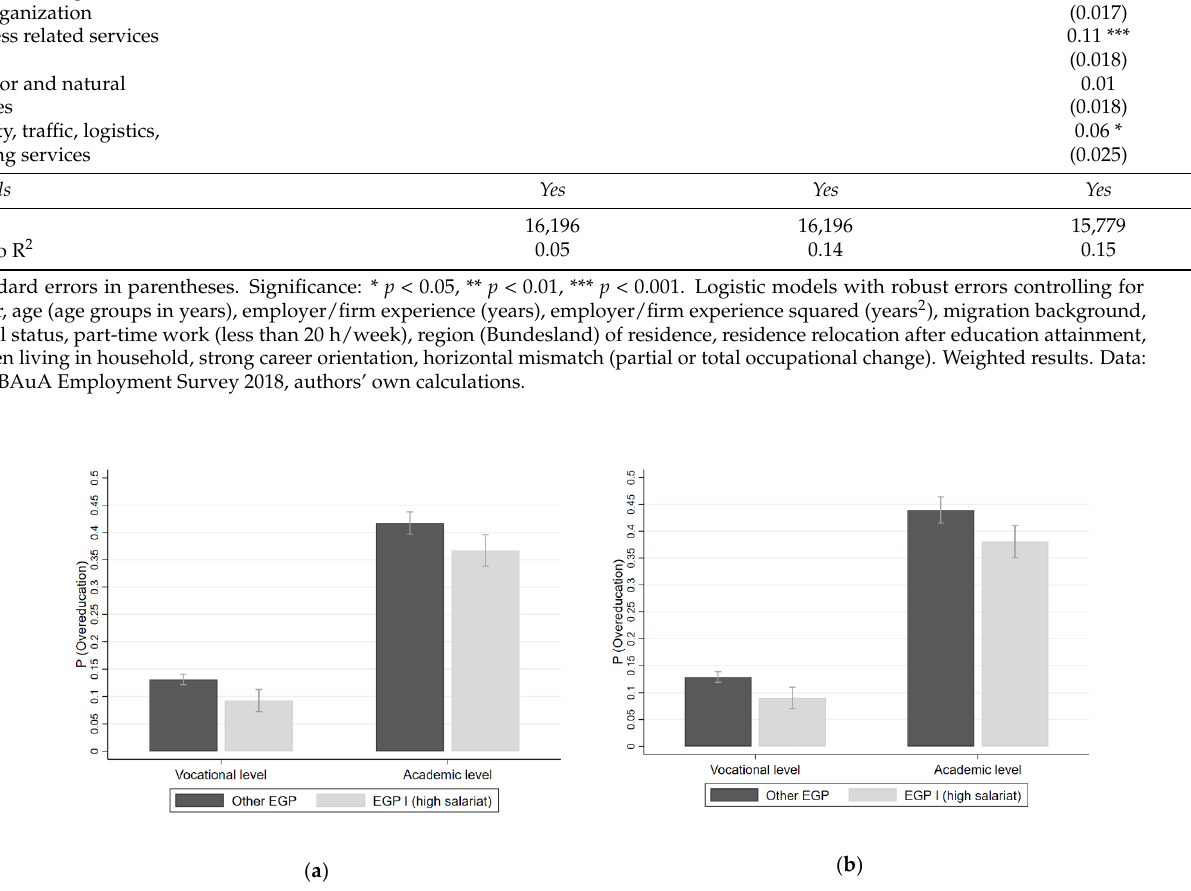
Figure A1. ( a ) Predicted probability of overeducation (objective indicator) (AME) (no control for fields of education); ( b ) Predicted probability of overeducation (objective indicator) (AME) (controlled for fields of education). Standard error bars at the 95-percent level. The results are based on logistic regression models adjusted for all the remaining control variables (see Section 3.3). Weighted results. Data: BIBB/BAuA Employment Survey 2018, authors’ own calculations.